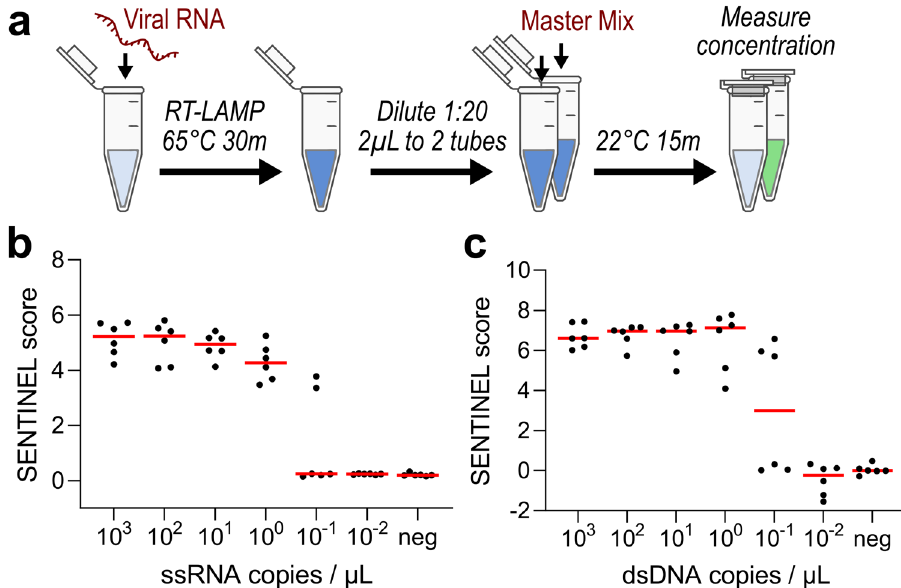
Fig. 2 Limit of detection for endonuclease-actuated nucleic acid detection. a Schematic of SENTINEL protocol, starting from synthetic, in vitro transcribed viral RNA. b and c Limit of detection on b ssRNA and c dsDNA input. Red lines correspond to median of six experimental replicates for each (dsDNA) plasmid encoding the N-gene, we performed (RT)- LAMP using 5 ′ phosphorothiolated LAMP primers, followed by